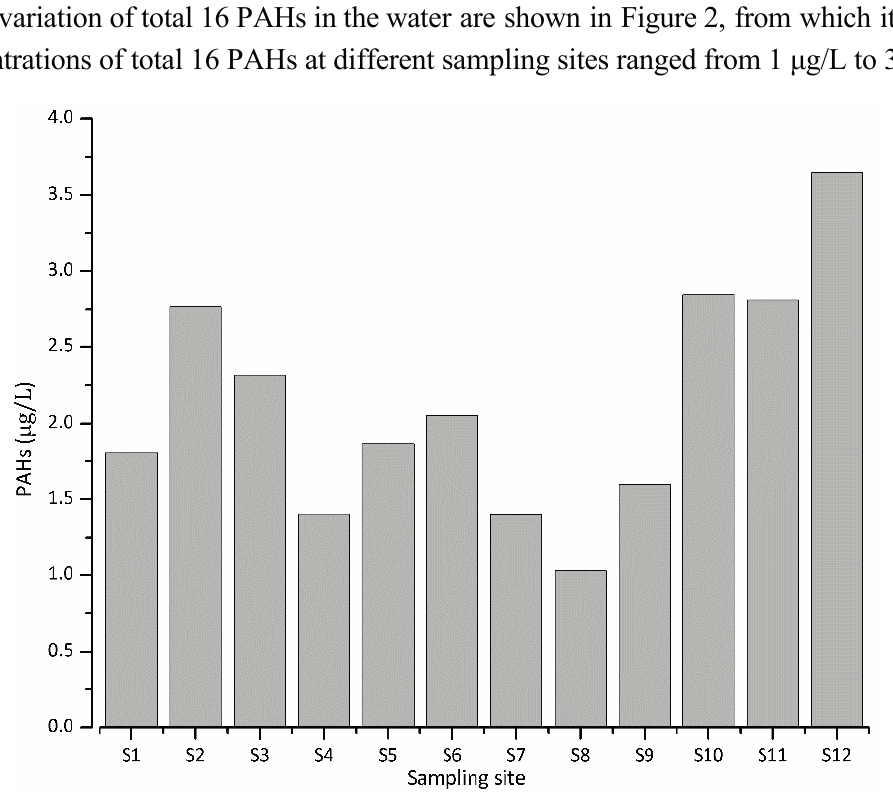
Figure 2. The concentration levels of total PAHs in the